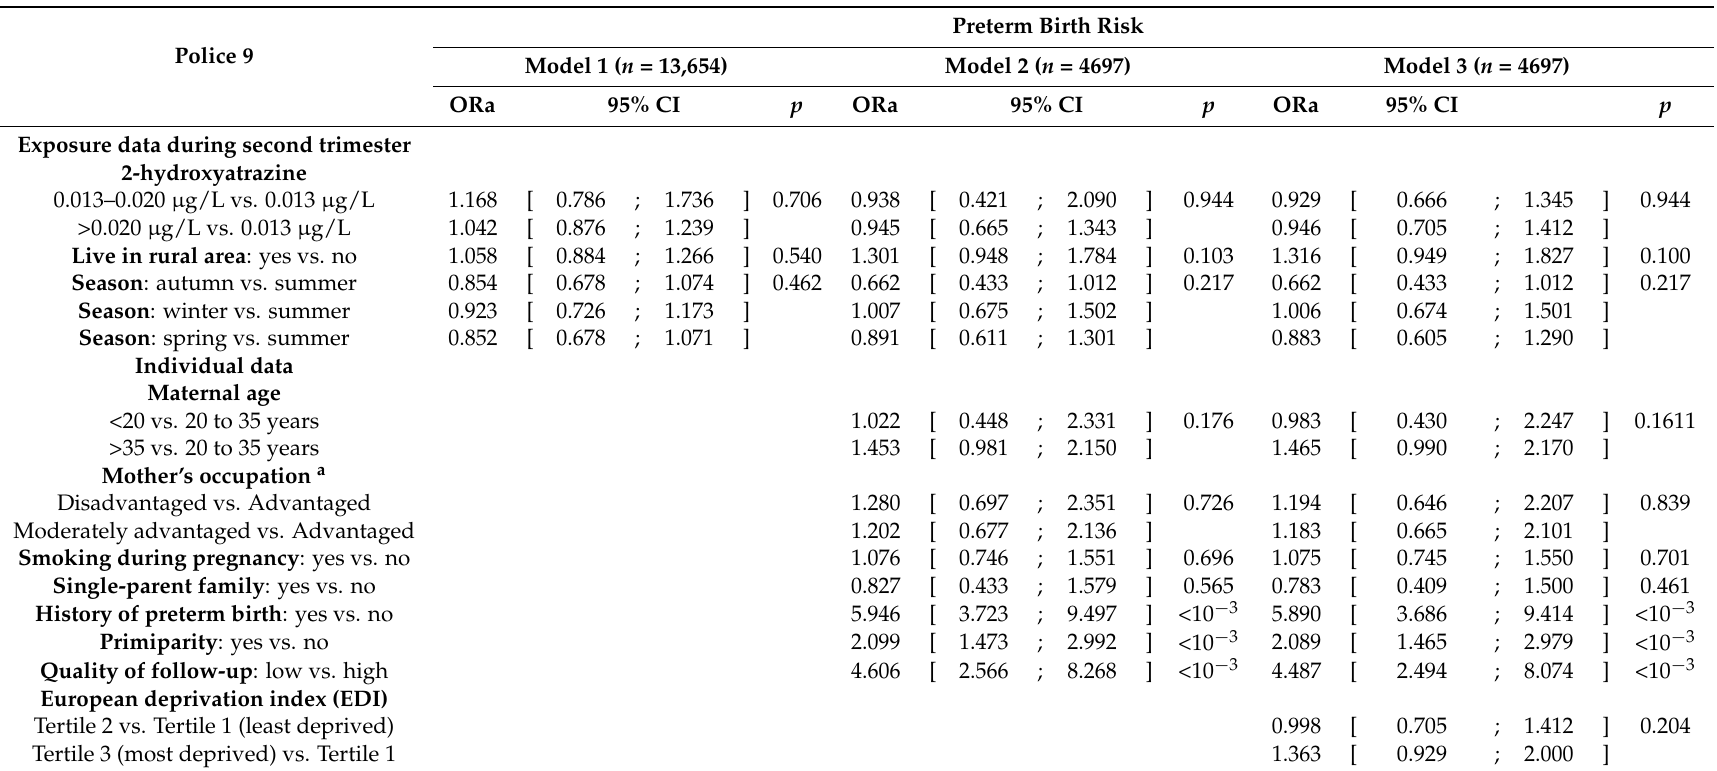
Table 3. Relation between exposure to 2-hydroxyatrazine in drinking-water during second trimester of pregnancy and prevalence of preterm birth babies. Multivariable analysis, Deux-Sèvres, France, 2005–2010.